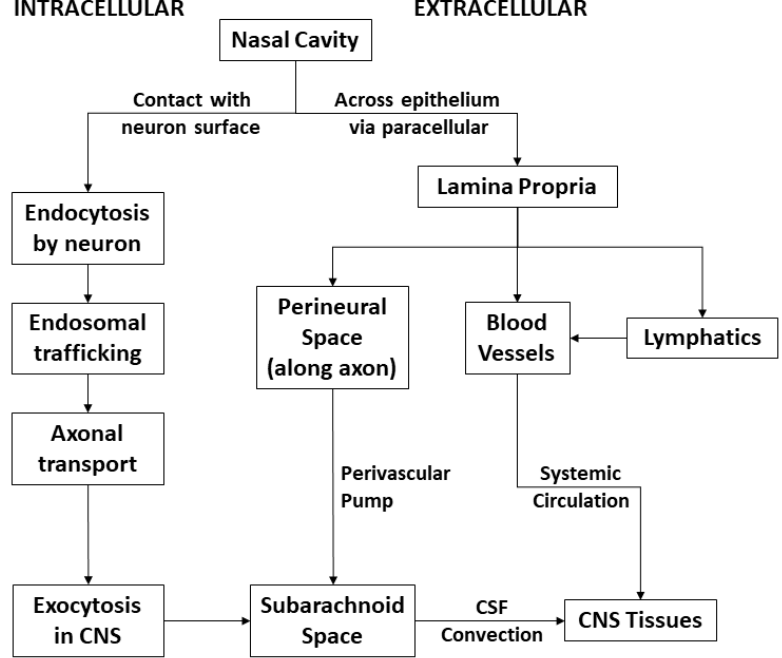
Figure 3. Schematic of intracellular and extracellular pathways for intranasal drug delivery.